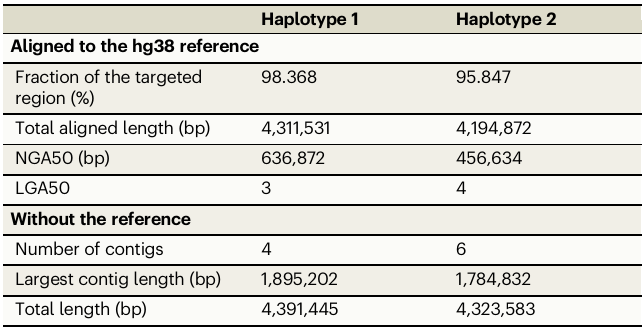
Table 2 | Statistics of two targeted assembled MHC haplotypes Haplotype 1 Haplotype